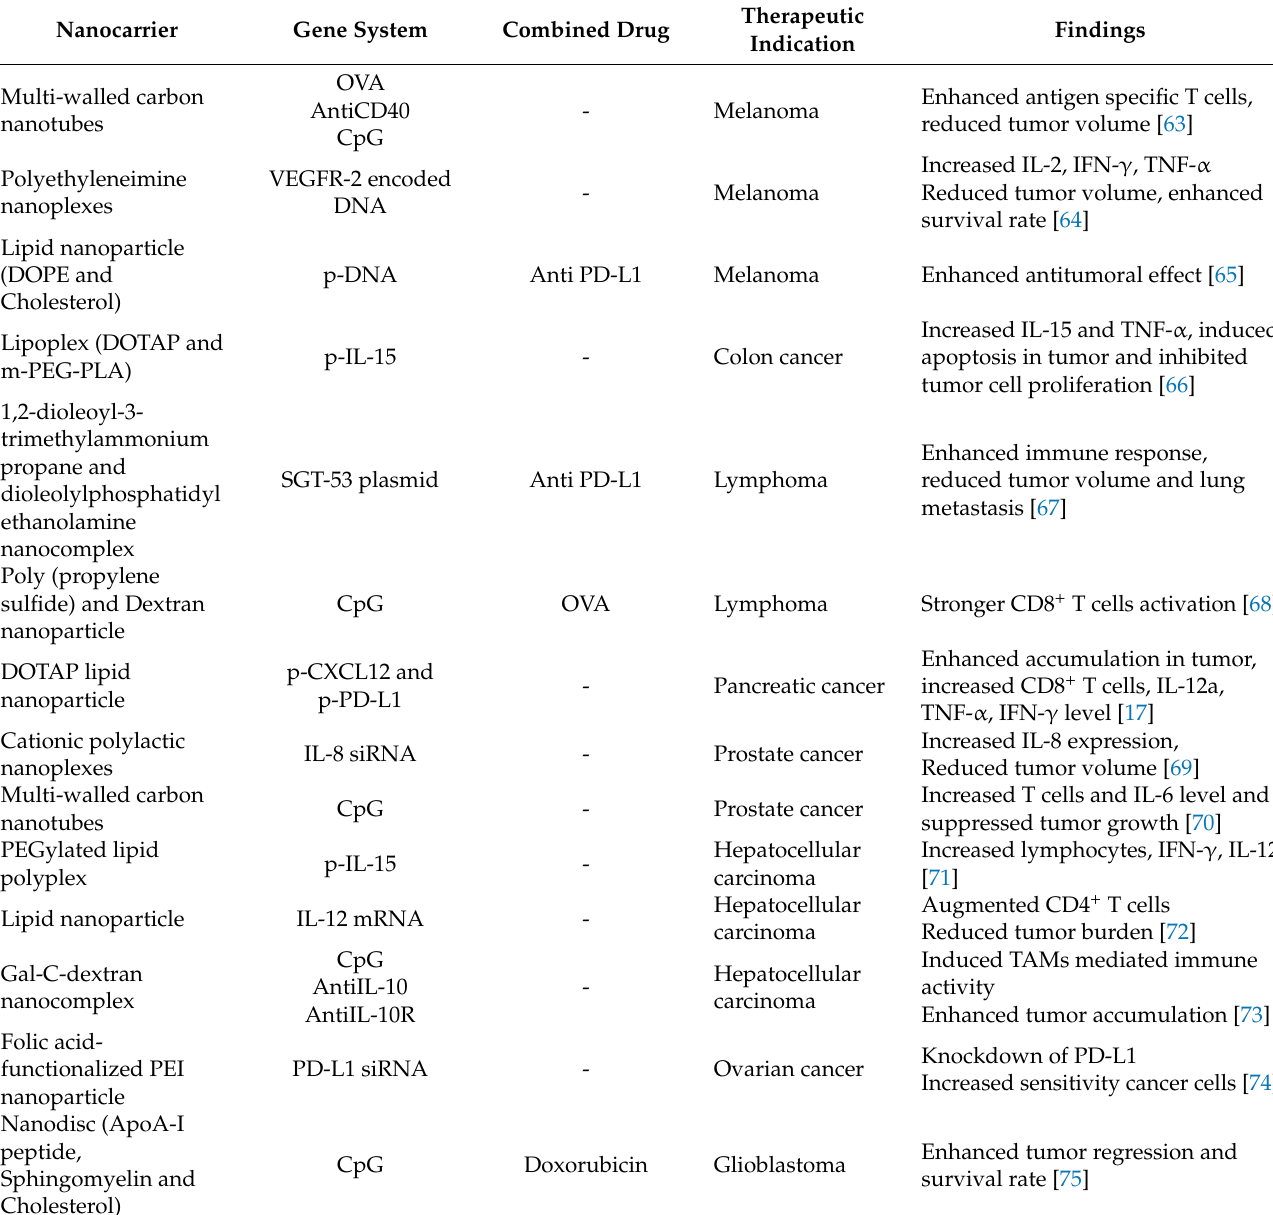
Table 4. Summary of several nanoparticulate gene delivery systems on cancer